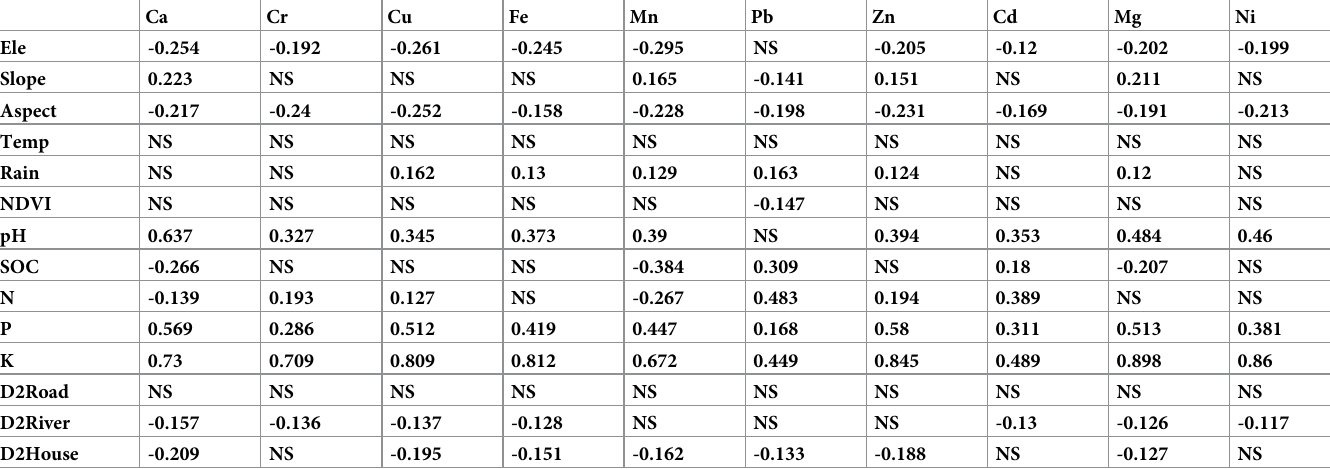
Table 4. Spearman coefficient between metal elements and explanatory variables (sample number = 300, p < 0.05, NS indicates no significance).